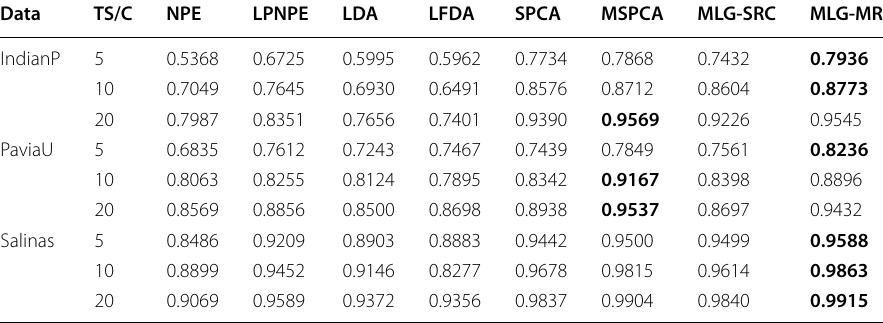
The best performances are marked in bold